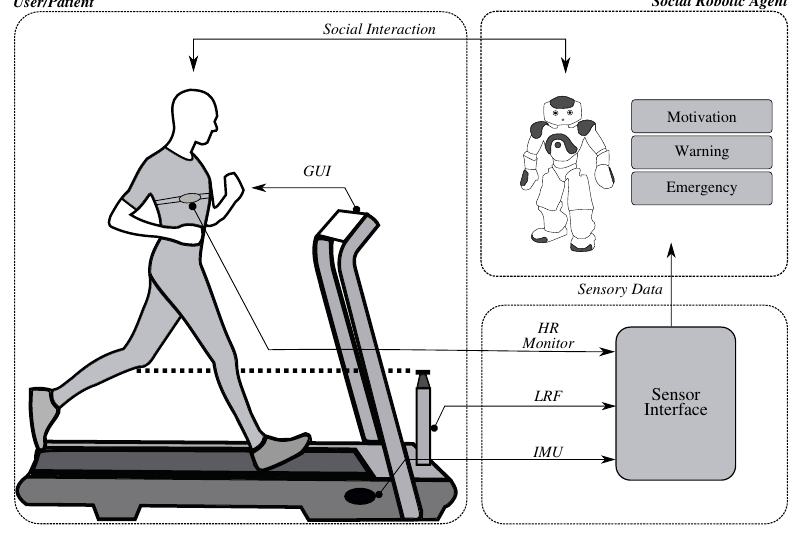
Figure 3. Experimental setup of a treadmill-based therapy at the cardiac rehabilitation facility.